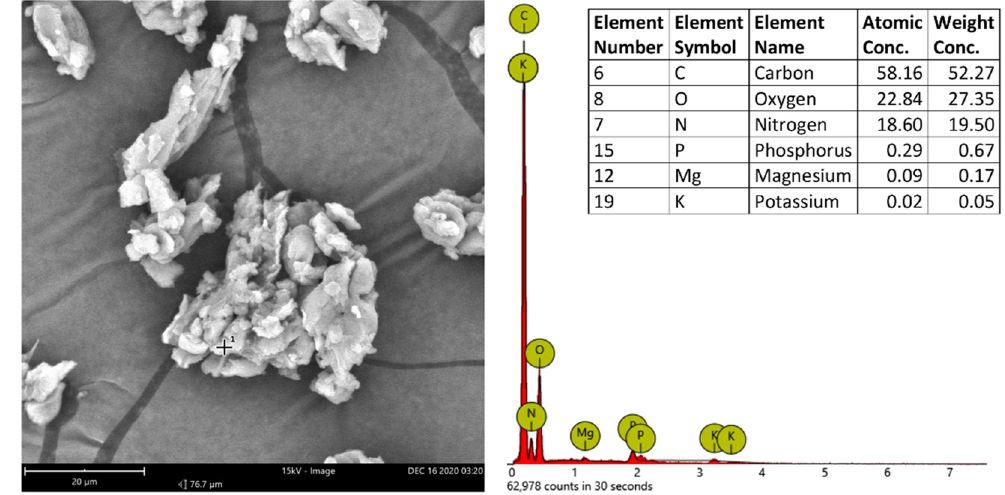
Figure 2: SEM image and EDS spectra of L. leucocephala extract